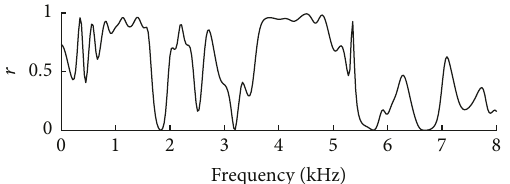
Figure 18: Correlation function of IC9 and piston slap